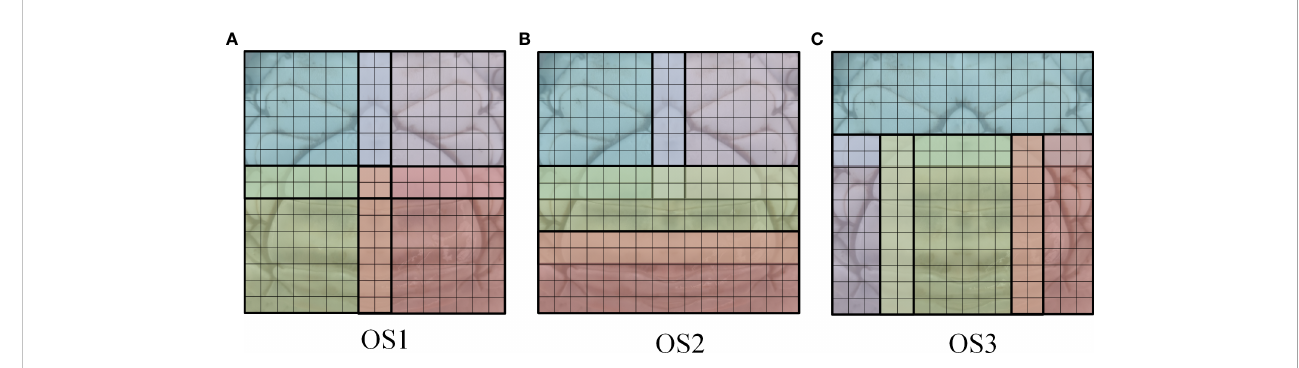
FIGURE 8 (A – C) Three overlapping partition